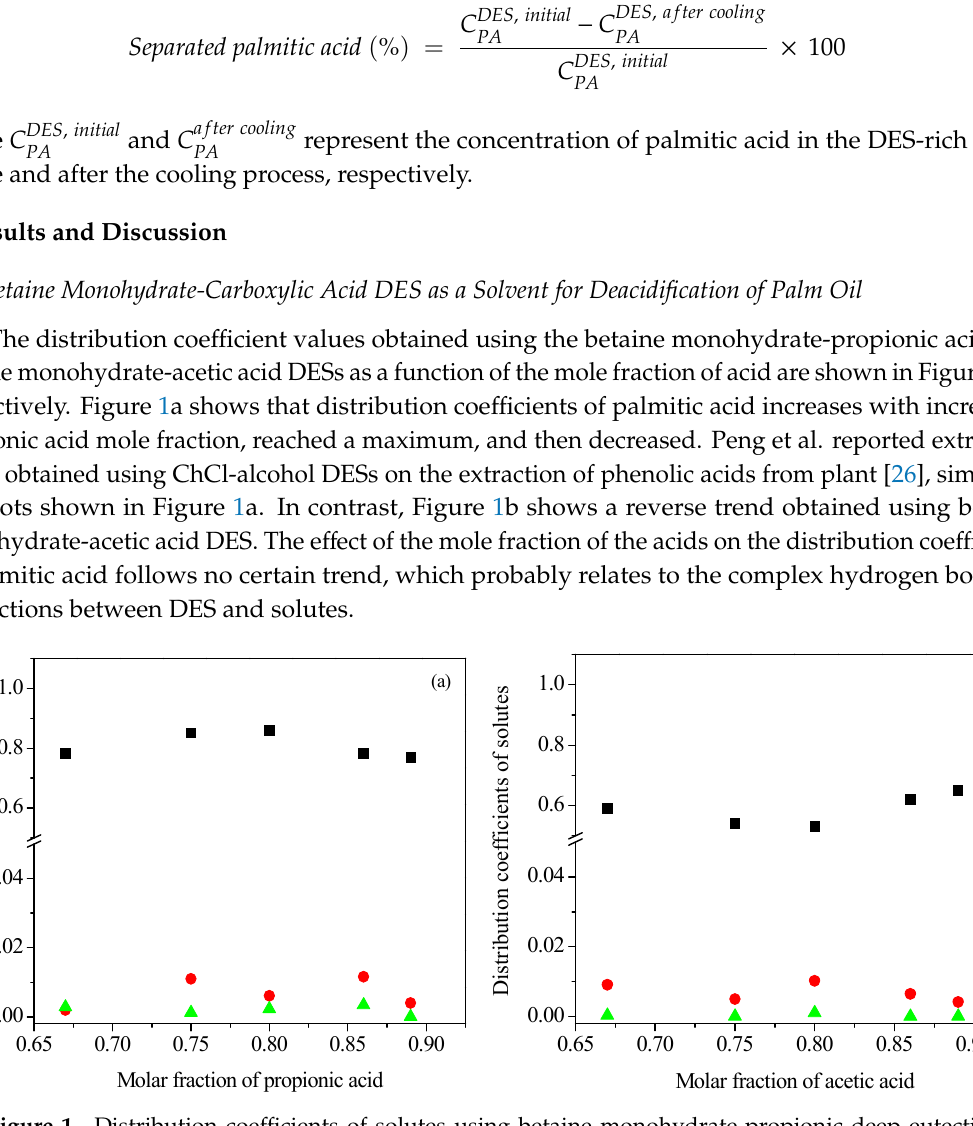
Figure 1. Distribution coefficients of solutes using betaine monohydrate-propionic deep eutectic solvents (DES) ( a ) and betaine monohydrate-acetic acid DES ( b ); ( ■ ) palmitic acid, ( ▲ ) β -carotene, ( ● ) α -tocopherol, volume ratio of oil to solvent of 1:2, and temperature of 40 °C for 2 h.